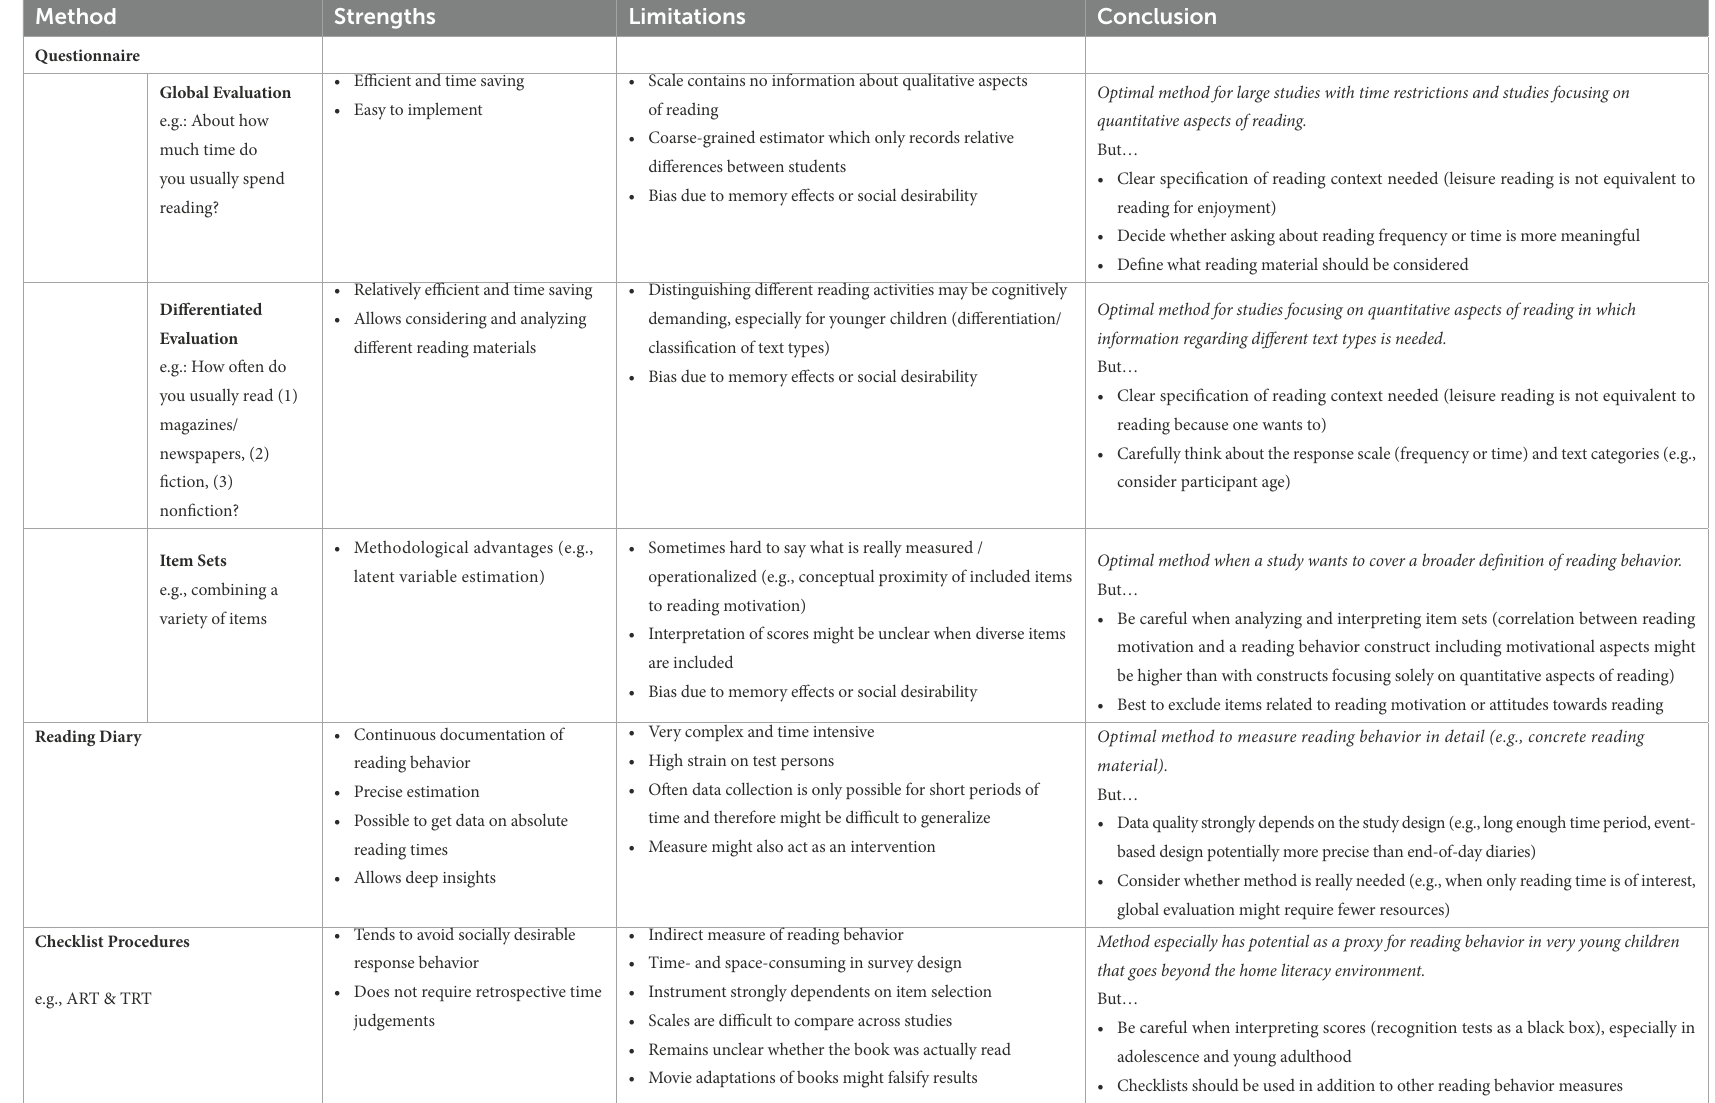
TABLE 1 Overview of advantages and disadvantages of the three methods to measure reading behavior in large-scale assessments and surveys in primary and secondary education.